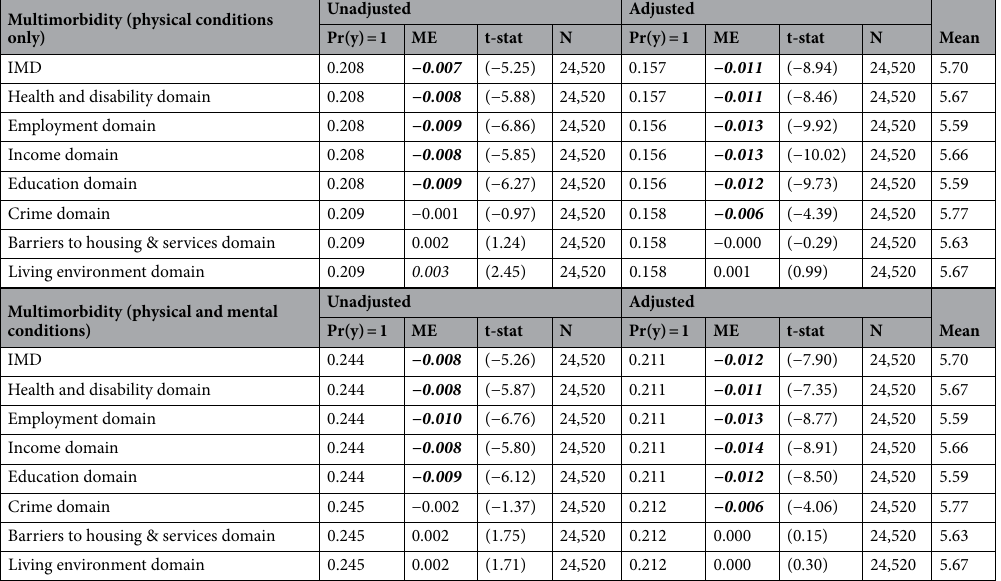
Table 4. Logistic regressions of multimorbidity on deciles of neighbourhood deprivation (IMD 2019 and domains). Marginal Effects (ME). Population estimates for England and Wales. Standard errors adjusted for clustering and stratification. All estimates that reach statistical significance ( p < 0.05) in italics; estimates in bold are statistically significant at p < 0.001. Source: Understanding Society (2020), Wave 10, linked with ONSPD (Nov 2020) and Index for Multiple Deprivation 2019 at the LSOA 2011